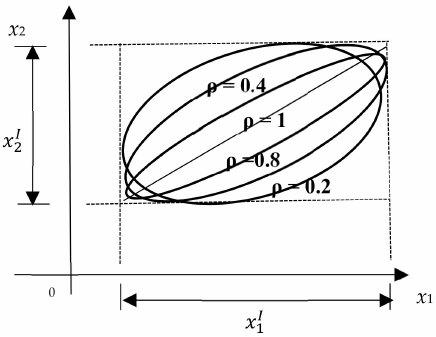
Figure 4. Two-dimensional ellipsoidal uncertainty domain of positive interaction coe ffi cient.